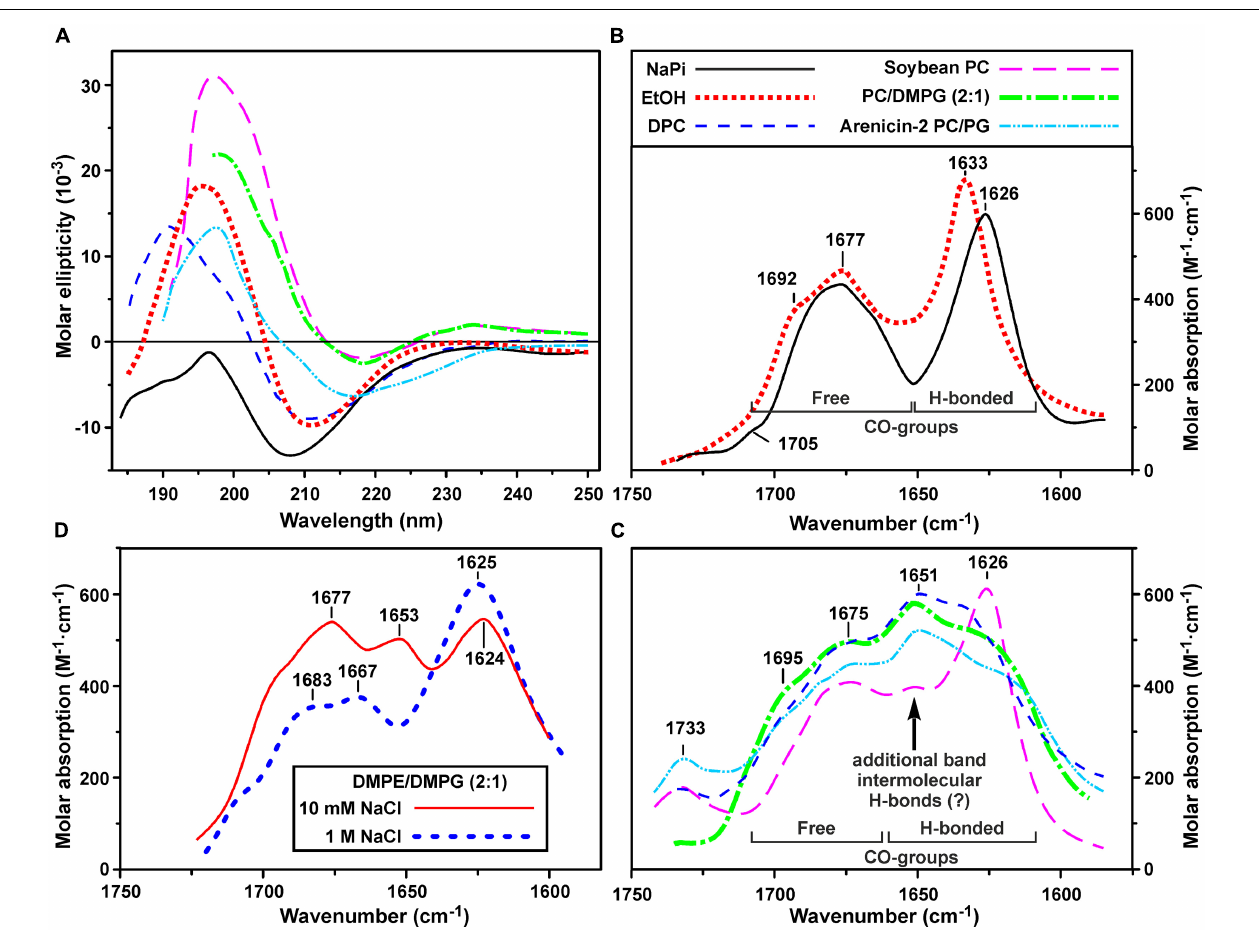
FIGURE 3 | Circular dichroism (CD) spectra (A) and amide I region of FTIR spectra (B–D) of ChDode in different environments. (A–C) Spectra in 10 mM phosphate buffer (pH 7.2), ethanol, DPC micelles (pH 4.0), soybean phosphocholine (PC) small unilamellar vesicles (SUVs, 10 mM NaPi, pH 7.2), soybean PC/DMPG (2:1) SUVs (NaPi, pH 7.2) are shown. Please see the used designations for (A–C) above (B) panel. The spectra of arenicin-2 in PC/PG (7:3) SUVs (Sychev et al., 2017a,b) are shown on the panels (A,C) for comparison. On the panel (C) : the intensity of FTIR spectrum in PC SUVs is lowered for clarity. Weak band at 1,733 cm - 1 is due to incomplete compensation of the phospholipid ν (C = O) absorption. (D) FTIR spectra in DMPE/DMPG (2:1) SUVs (10 mM NaPi, pH 7.2) in the presence of 10 mM or 1 M NaCl. The intensity of the last spectrum is lowered for